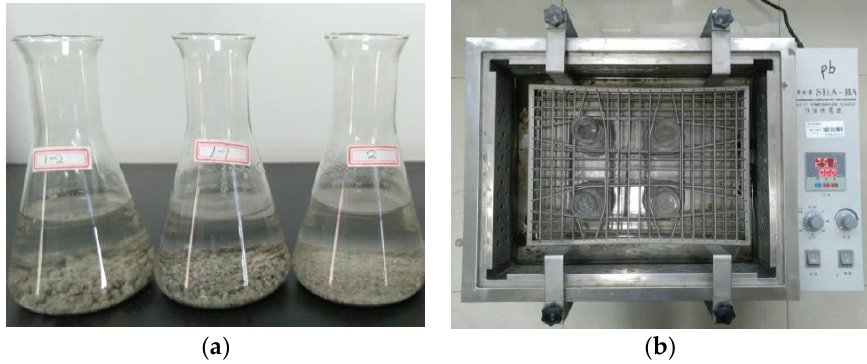
Figure 2. HVEP test in this study: ( a ) Liquid waste samples; ( b ) the horizontal-vibration machine.